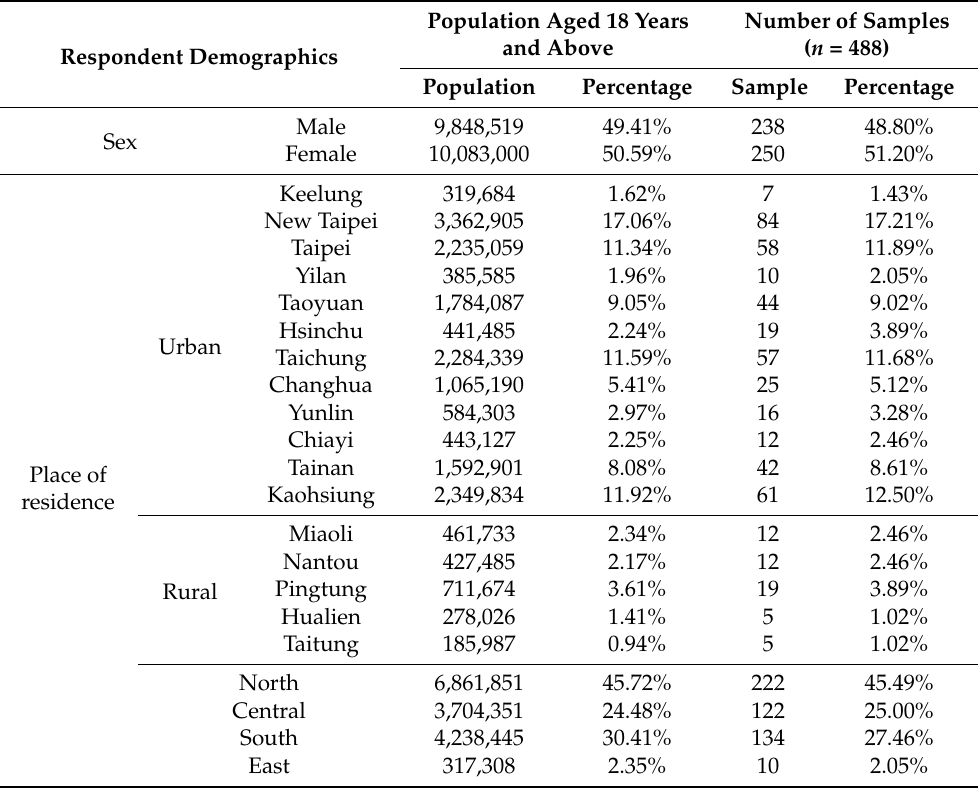
Table 2. Comparison between valid questionnaires and